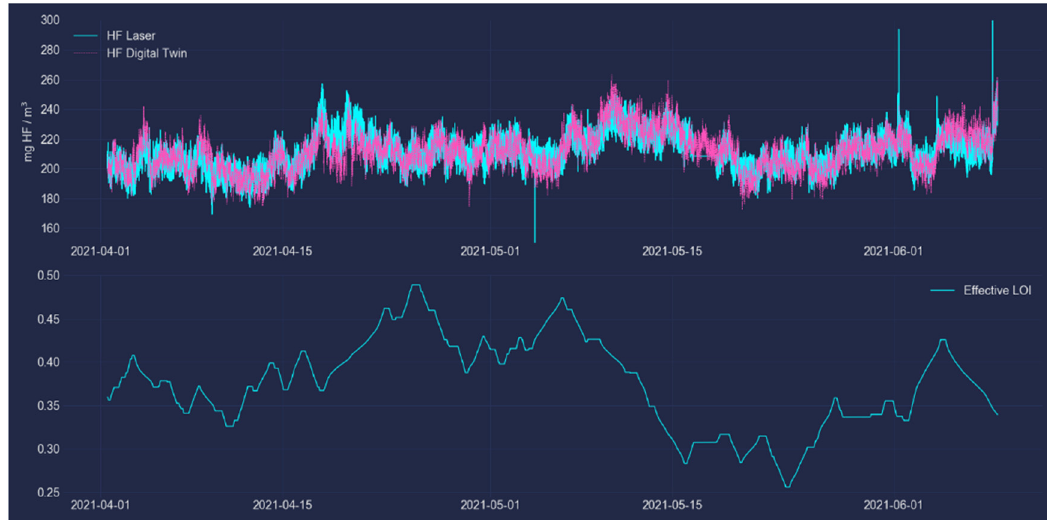
Figure 3: Results from the digital twin technology for the GTC. Digital twin predictions and agreement with measurement can be monitored by operators. ( Top ) The hybrid digital twin predictions for HF - concentration in the fumes closely follow the dynamics of the process measurements made via HF - laser. ( Bottom ) Self - adaptation of a model parameter to improve digital twin prediction